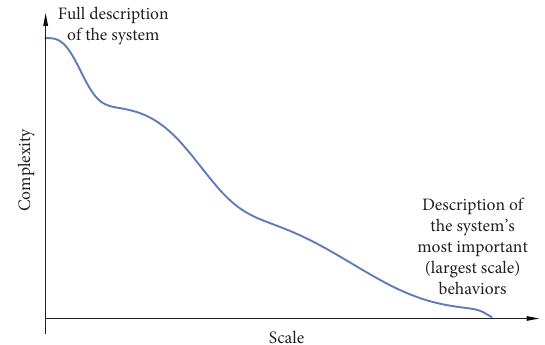
Figure 9: A representative complexity profile of a complex system. Understanding all the details (i.e., all of the small-scale behaviors) is impossible and unnecessary; the most important information is contained in the large-scale behaviors. However, for systems for which mean-field theory does not apply, characterizing these be- haviors will involve more than a simple